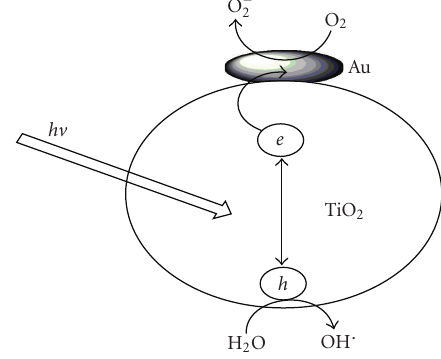
Scheme 1: Interfacial charge transfer process of gold-doped TiO 2 nanocomposites under the irradiation of UV